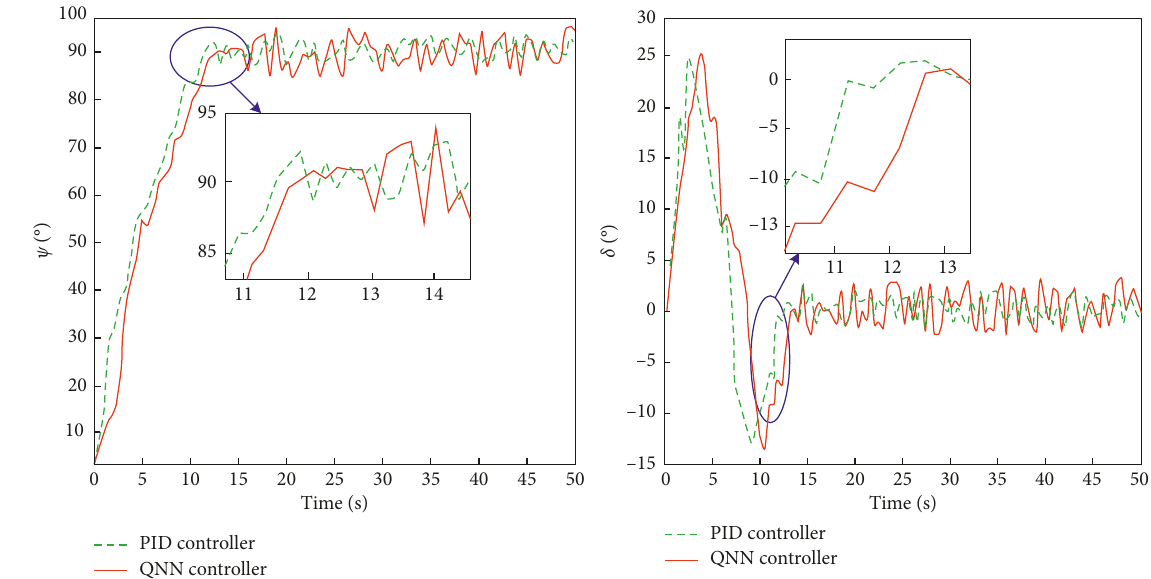
Figure 9: The practical course keeping control results of IASV